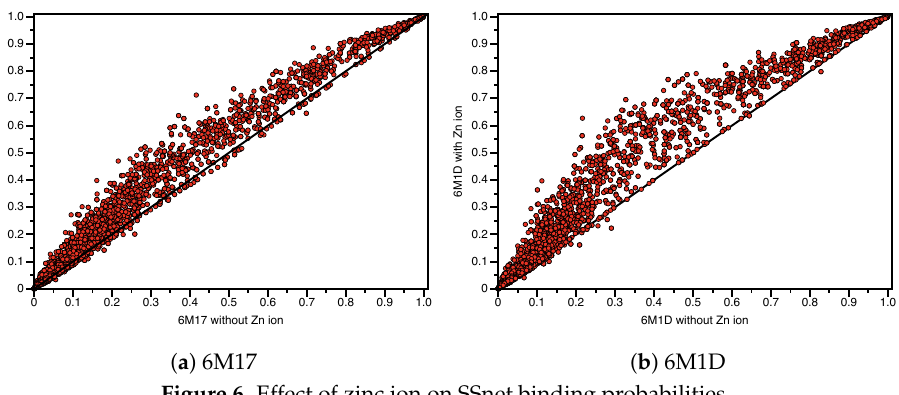
Figure 6. Effect of zinc ion on SSnet binding